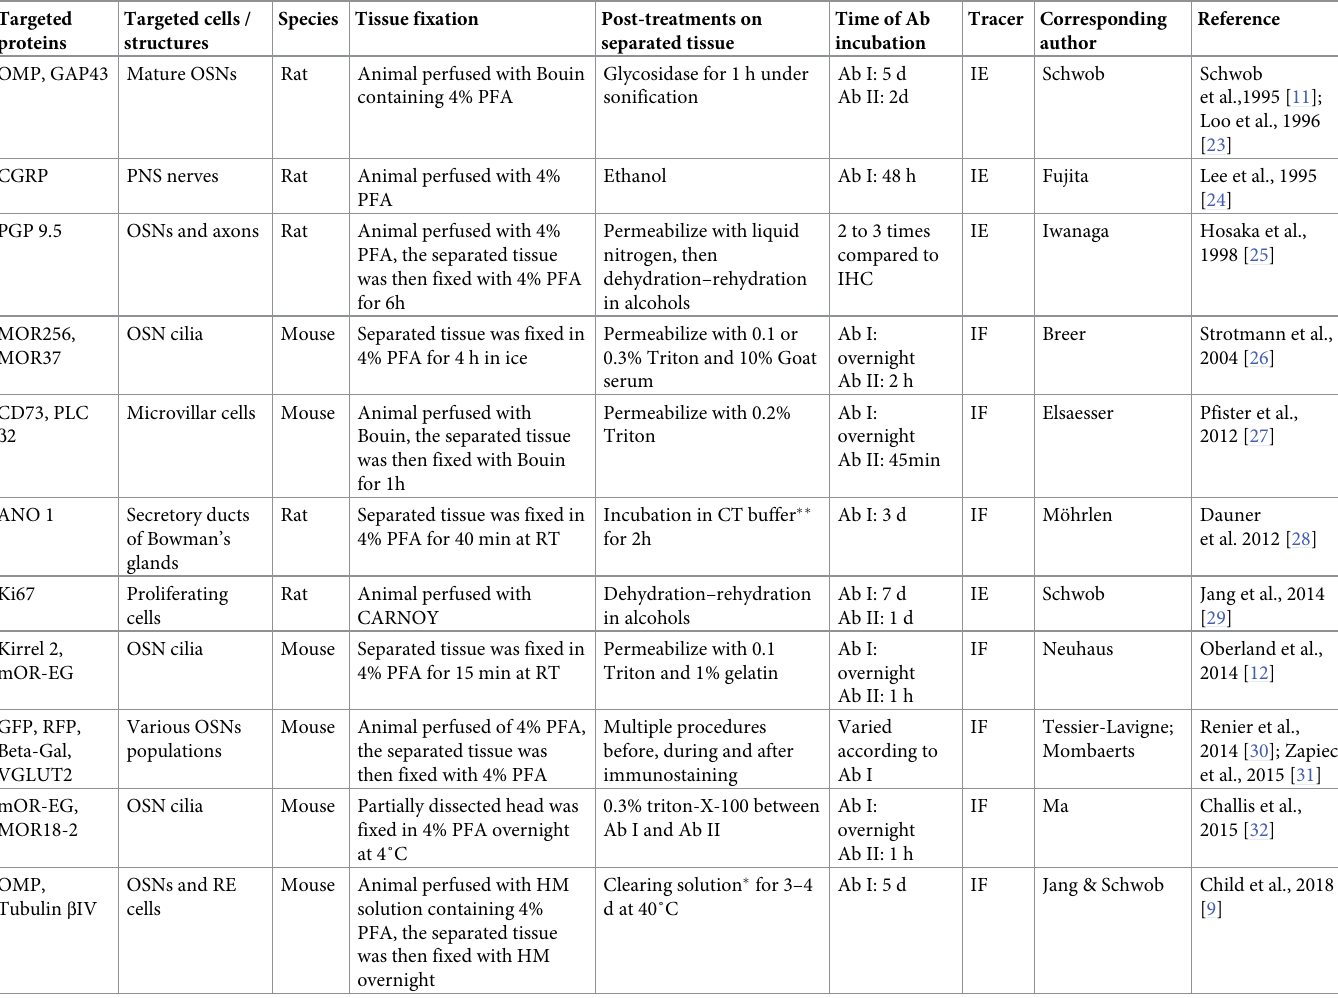
Table 2. Summary of the reported techniques of immunostaining on flat mounted septum mucosa. Targeted Targeted cells / proteins